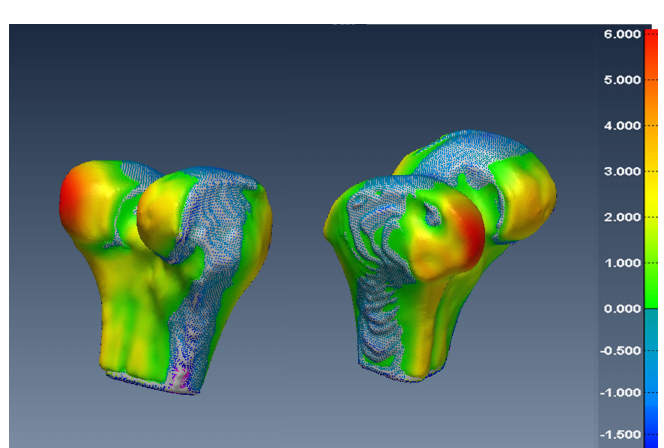
Figure 14. Two views of the colour-coded signed distance in mm between the U-Net 3D mesh and the SKI10 3D mesh for the femur.